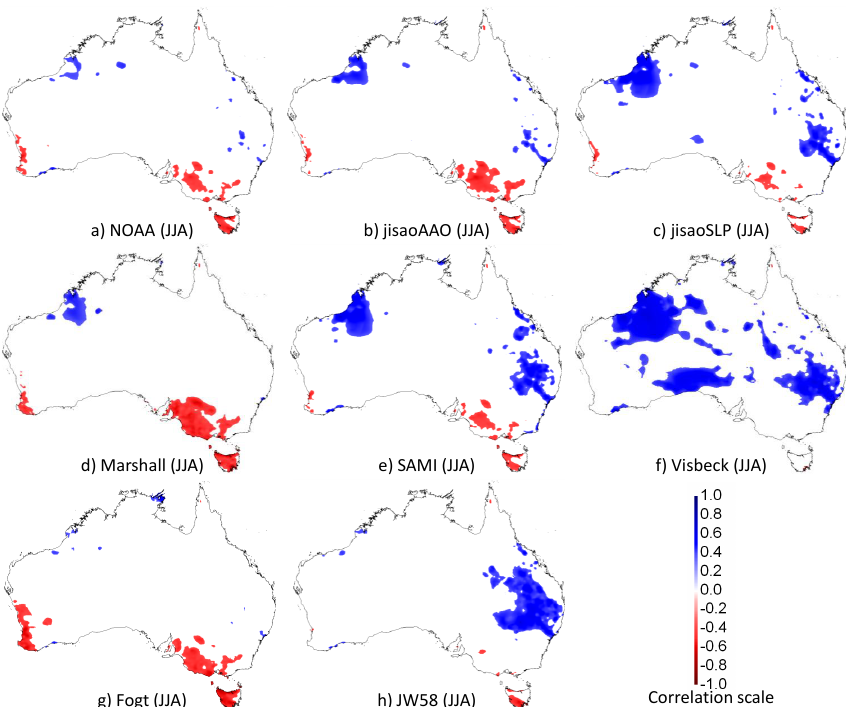
Fig. 6. Correlations between total winter (JJA) rainfall and winter SAM indices, 1979–2002 (a) NOAA; (b) jisaoAAO; (c) jisaoSLP; (d) Marshall; (e) SAMI; (f) Visbeck; (g) Fogt and (h) JW58. Note: only correlations that are statistically significant at the 95th percentile are